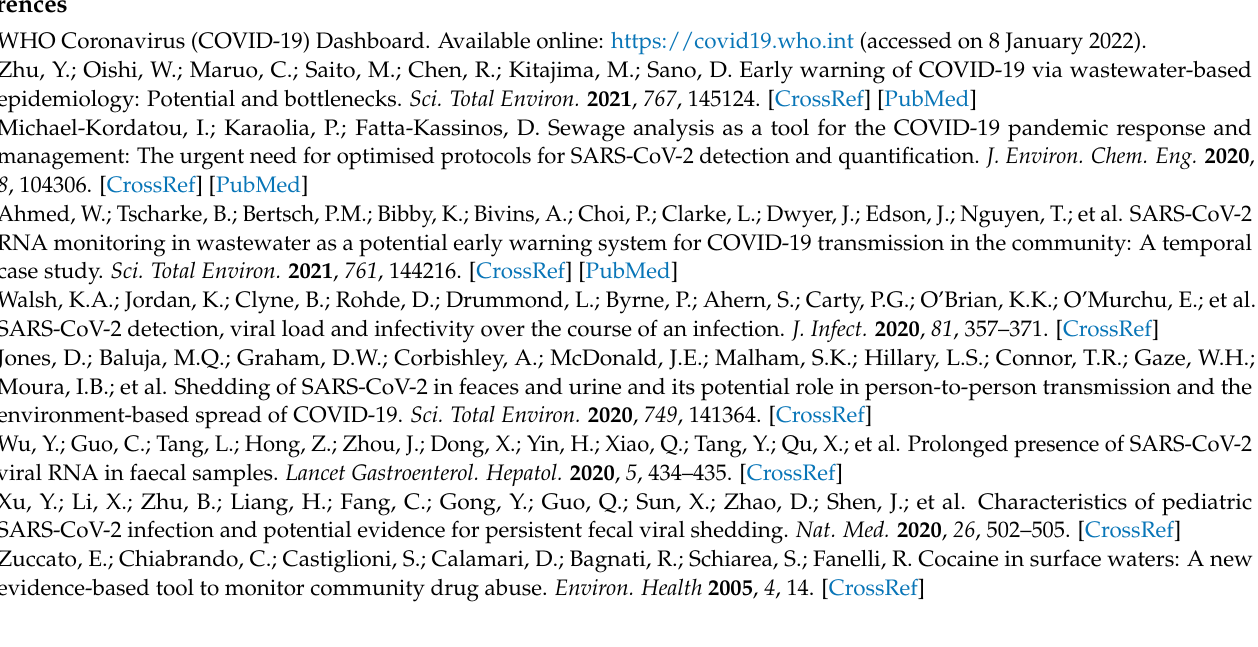
relative standard deviation (RSD) at UDD WWTP; Table S4: Weekend and weekday average TP and TN population estimations and corresponding relative standard deviation (RSD) at RAN WWTP; Table S5: UDD WWTP Ct values and calculated Ct difference between replicates, as well as calculated concentrations in each sample. Each replicate is based on an average value from RT-qPCR triplicates targeting the N1 gene of SARS-CoV-2; Table S6: RAN WWTP Ct values and calculated Ct difference between replicates, as well as calculated concentrations in each sample. Each replicate is based on an average value from RT-qPCR triplicates targeting the N1 gene of SARS-CoV-2; Table S7: UDD WWTP Ct values from RT-qPCR of PMMoV and calculated Ct difference, as well as calculated concentrations in each sample replicate. Each replicate is based on an average value from RT-qPCR duplicates; Table S8: RAN WWTP Ct values from RT-qPCR of PMMoV and calculated Ct difference, as well as calculated concentrations in each sample replicate. Each replicate is based on an average value from RT-qPCR